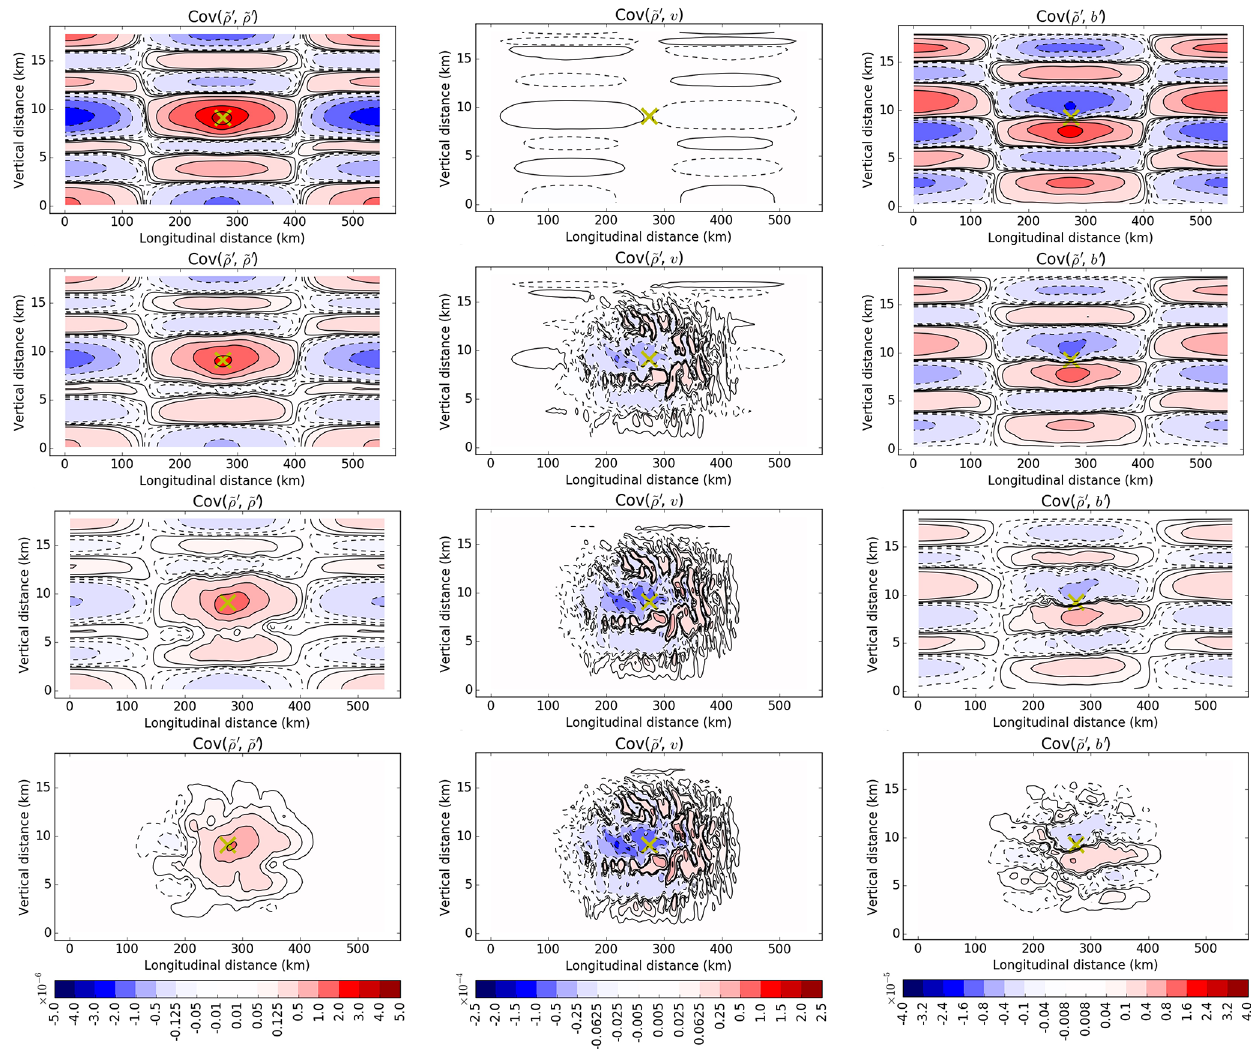
Figure 3. Implied background error covariances of ˜ ρ (cid:48) (leftmost column; Cov( ˜ ρ (cid:48) , ˜ ρ (cid:48) )), v (middle column; Cov( ˜ ρ (cid:48) , v )) and b (cid:48) (rightmost column; Cov( ˜ ρ (cid:48) , b (cid:48) )) with respect to a ˜ ρ (cid:48) point (yellow cross) near the centre of the domain for the first cycle after cold start. The rows represent configurations (a), (b), (c), and (d), respectively (see the list near the start of Sect. 4). Negative values have contours that are